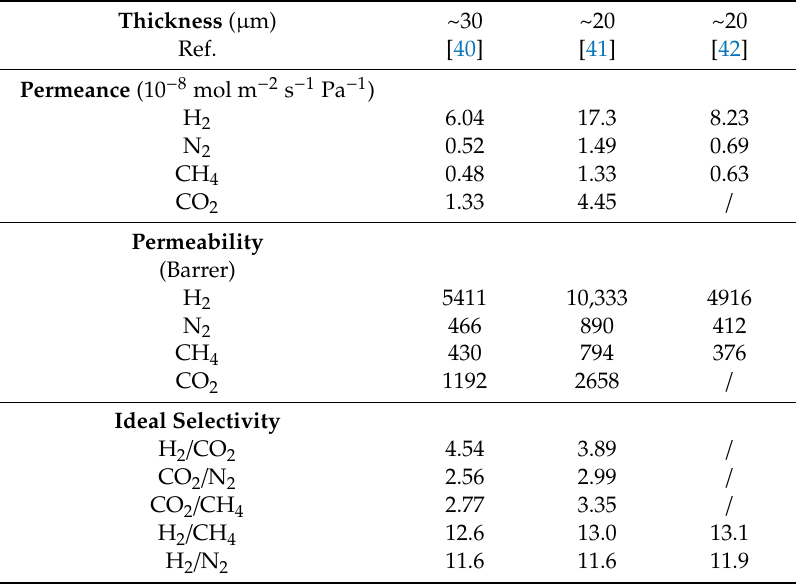
Table 3. The single-gas permeability and ideal selectivity of pure ZIF-8 membranes [55]. Thickness ( µ m) ~30 ~20 ~20